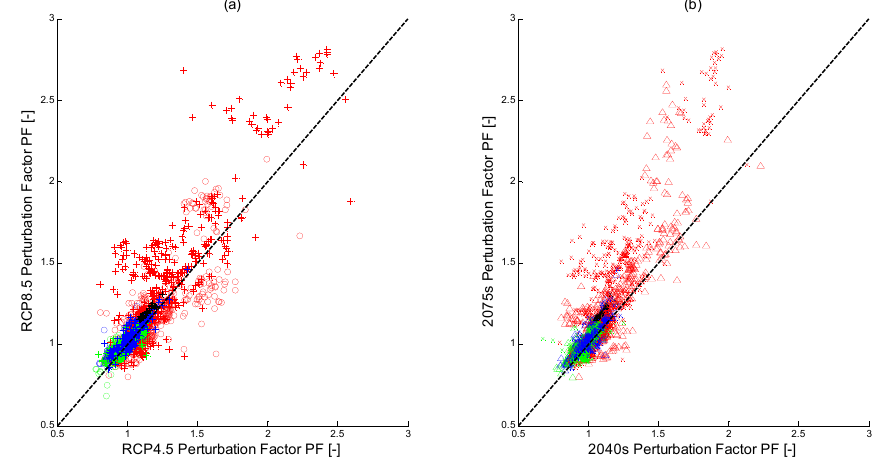
Figure 17. Annual precipitation perturbation factors, ( a ) RCP8.5 vs. RCP4.5, for the 2040s (o) and 2075s (+); ( b ) 2075s vs. 2040s for RCP4.5 ( Δ ) and RCP8.5(x), Red = LR GCMs, Blue = HR GCMs and Green = MR